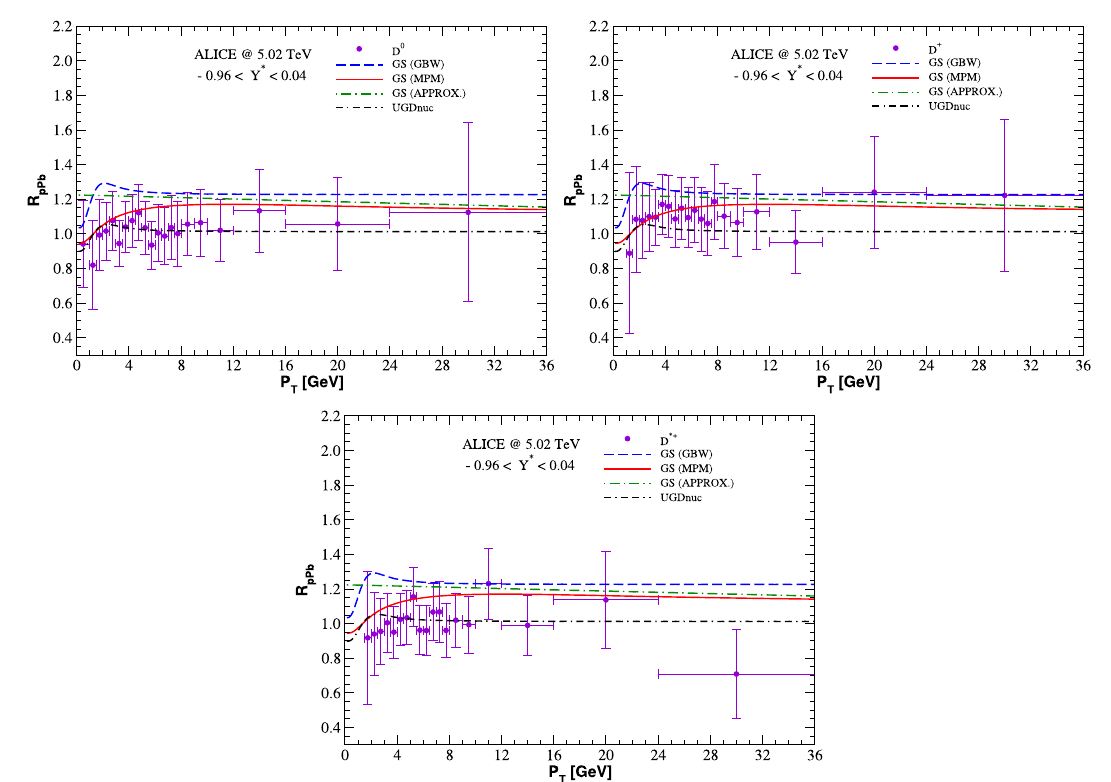
Fig. 6 The nuclear modification factor for D 0 (upper left panel), D + (upper right panel), and D ∗+ (bottom panel) meson production in pPb √ s = 5 . 02 TeV considering − 0 . 96 < Y ∗ < 0 . 04. The collisions at